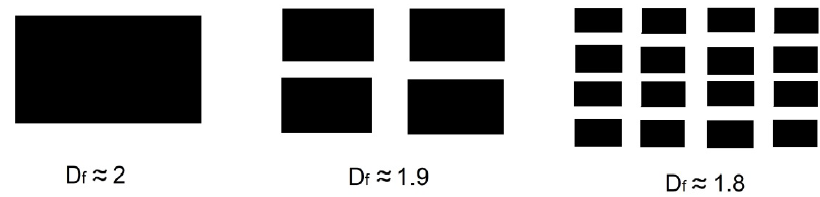
Figure 6. Effect of the size of objects with the same total area on fractal